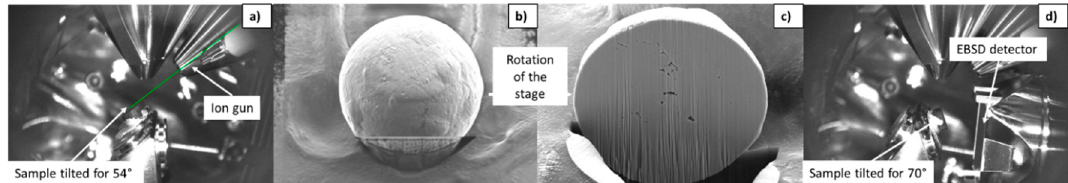
Figure 1. Particle being prepared for EDS and EBSD analyses. ( a ) Ion milling and polishing, ( b ) FIB image during milling, ( c ) a sample in a position for EDS analysis, ( d ) a sample in a position for EBSD analysis.